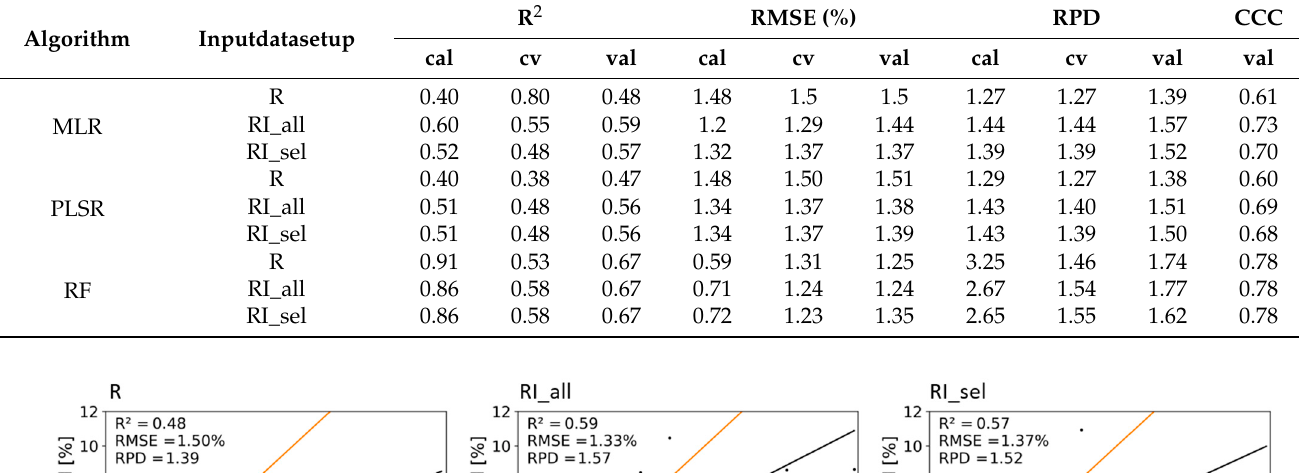
Table 4. Calibration (cal), cross validation (cv) and first independent validation (val) accuracies for MLR, PLSR and RF using R, RI_all and RI_sel.